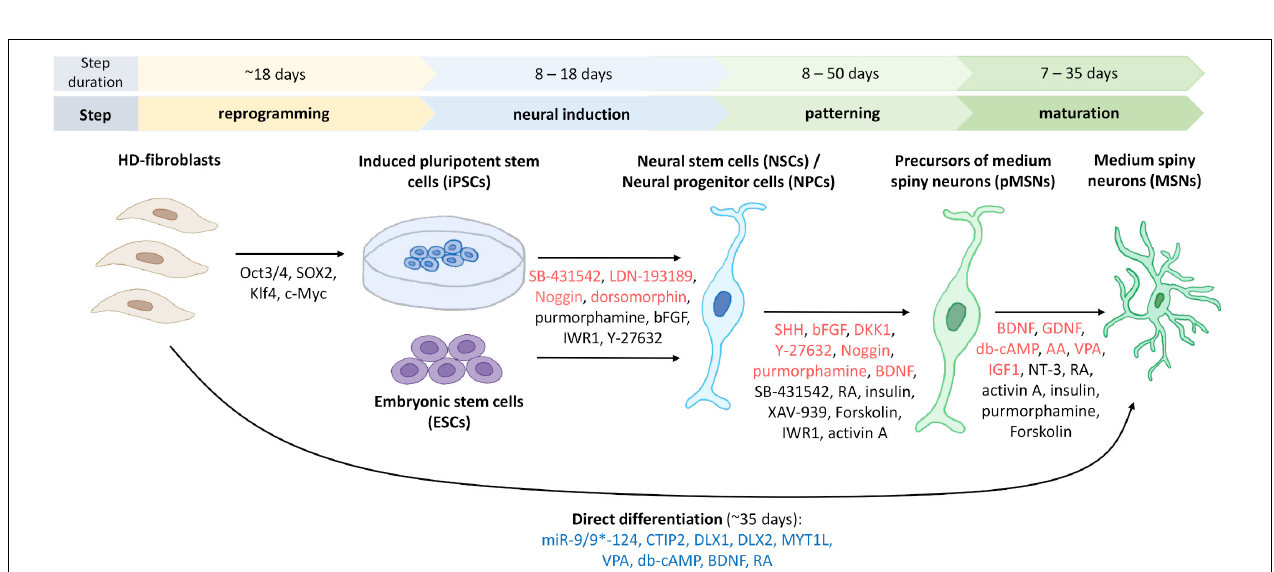
FIGURE 3 | Generation of human striatal MSNs from fibroblasts and stem cells. To reprogram fibroblasts into induced pluripotent stem cells (iPSCs), four transcription factors are used to transduce cells from HD patients (Victor et al., 2018). Indicated in red are the most commonly used factors for neural induction of iPSCs or embryonic stem cells (ESCs) to obtain neural stem cells (NSCs)/neural progenitor cells (NPCs), and for differentiation of progenitors and mature GABA-ergic medium spiny neurons, pMSNs and MSNs, respectively. Marked in black are factors used for neural induction or differentiation only in one or two protocols, which are discussed in the manuscripts. For direct differentiation, microRNA-9/9*-124, and other factors that are indicated in blue were used (Victor et al., 2014). The duration of each of the differentiation steps differs according to the various protocols. Figure summarizes fourteen protocols describing the generation of human striatal MSNs from iPSCs (Zhang et al., 2010; Delli Carri et al., 2013; Arber et al., 2015; Nekrasov et al., 2016; Adil et al., 2018; Comella-Bolla et al., 2020; Grigor’eva et al., 2020; Vigont et al., 2021), fibroblasts (Victor et al., 2014), ESCs (Nicoleau et al., 2013; Arber et al., 2015; Wu M. et al., 2018), NSCs (El-Akabawy et al., 2011), and NPCs (Lin et al., 2015). Using bFGF and neural media for culturing, it is possible to differentiate iPSCs to induced neural stem cells (iNSCs) and then transplant them into the striatal region of the mouse brain where they differentiate into MSNs (not shown) (Al-Gharaibeh et al., 2017).